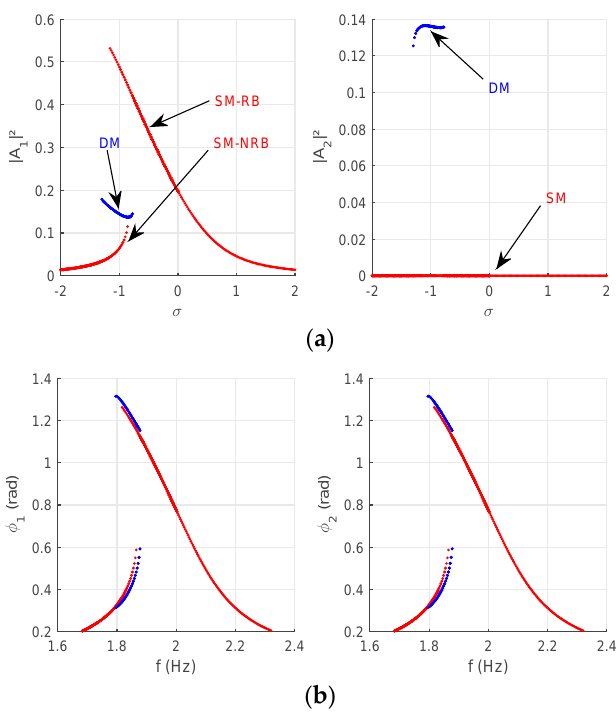
Figure 2. Deterministic ( a ) modal amplitudes | A 1 | 2 and | A 2 | 2 and ( b ) physical amplitudes φ 1 and φ 2 of the pendulums responses.